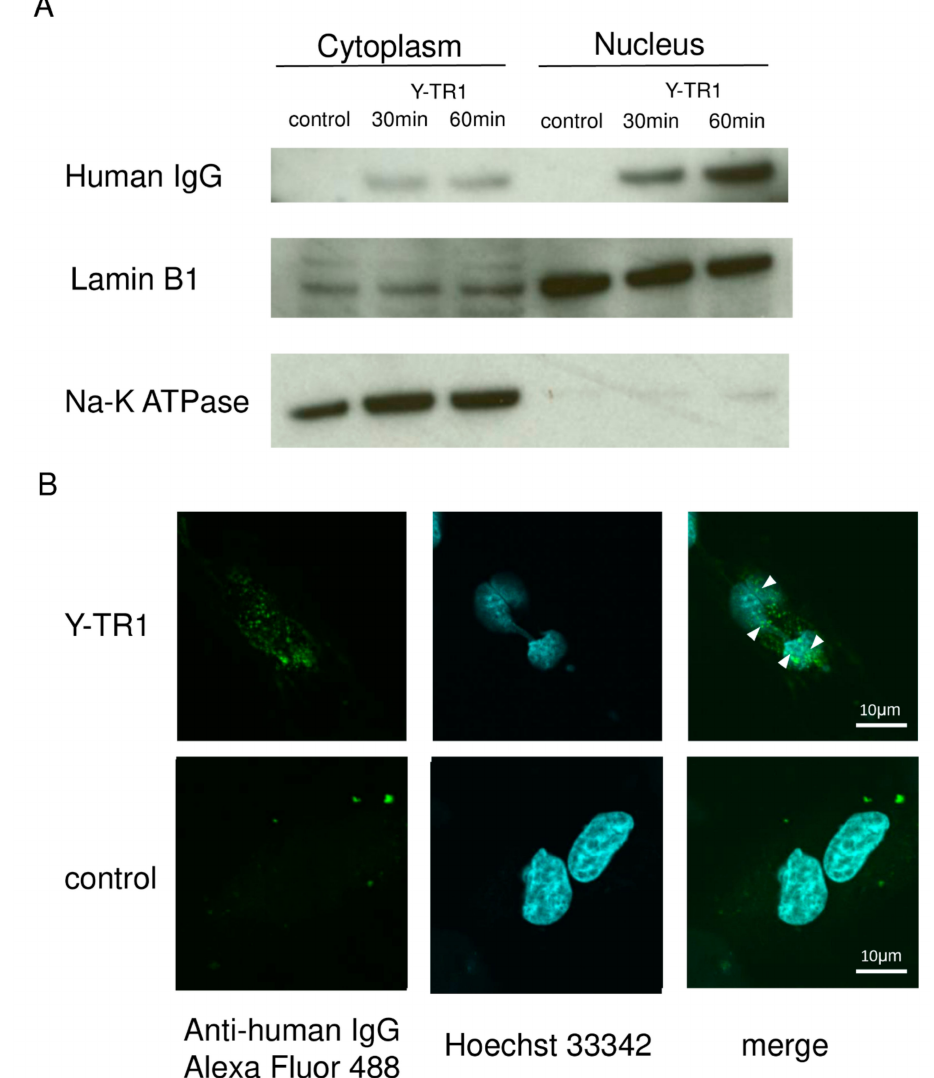
Figure 5. Nuclear translocation of Y-TR1. ( A ) Western blot analysis using anti-human IgG antibody detected Y-TR1 in the cytoplasm and the nuclear fraction of Y-TR1 treated CD26 positive JMN cells after 30 min and 60 min. Lamin B1 and Na-K ATPase were used as loading controls of the nuclear and cytoplasm fraction; ( B ) immunofluorescence staining observed under confocal laser microscopy of fixed JMN cells following 1 h of Y-TR1 treatment with the Alexa Fluor 488 labeled anti-human IgG antibody. Nuclear staining was done with Hoechst 33342. Localization of Y-TR1 (green) was observed in the nucleus (blue) as indicated by the white arrows. Scale bar: 10 µ